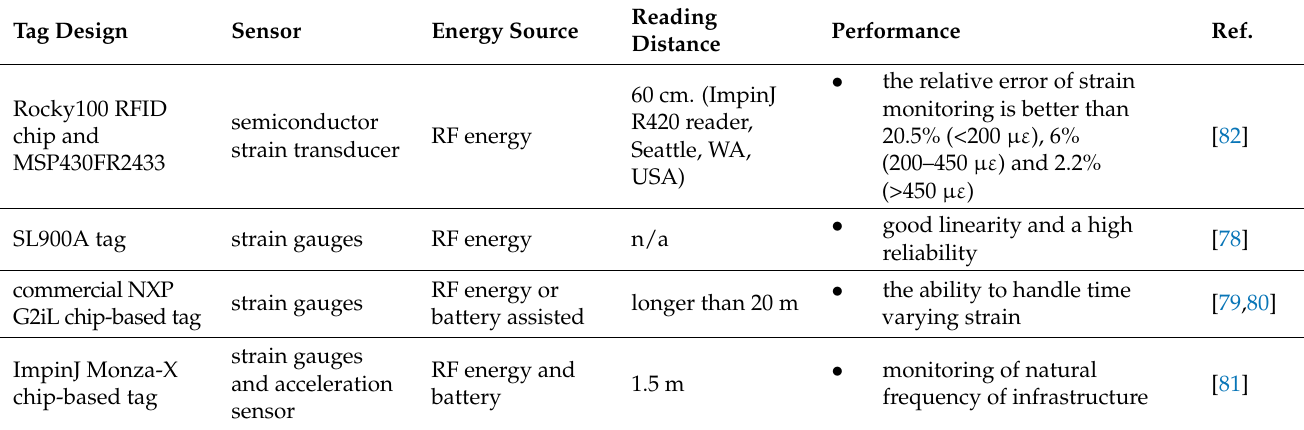
Table 5. Digitally integrated RFID sensor tags for SHM.